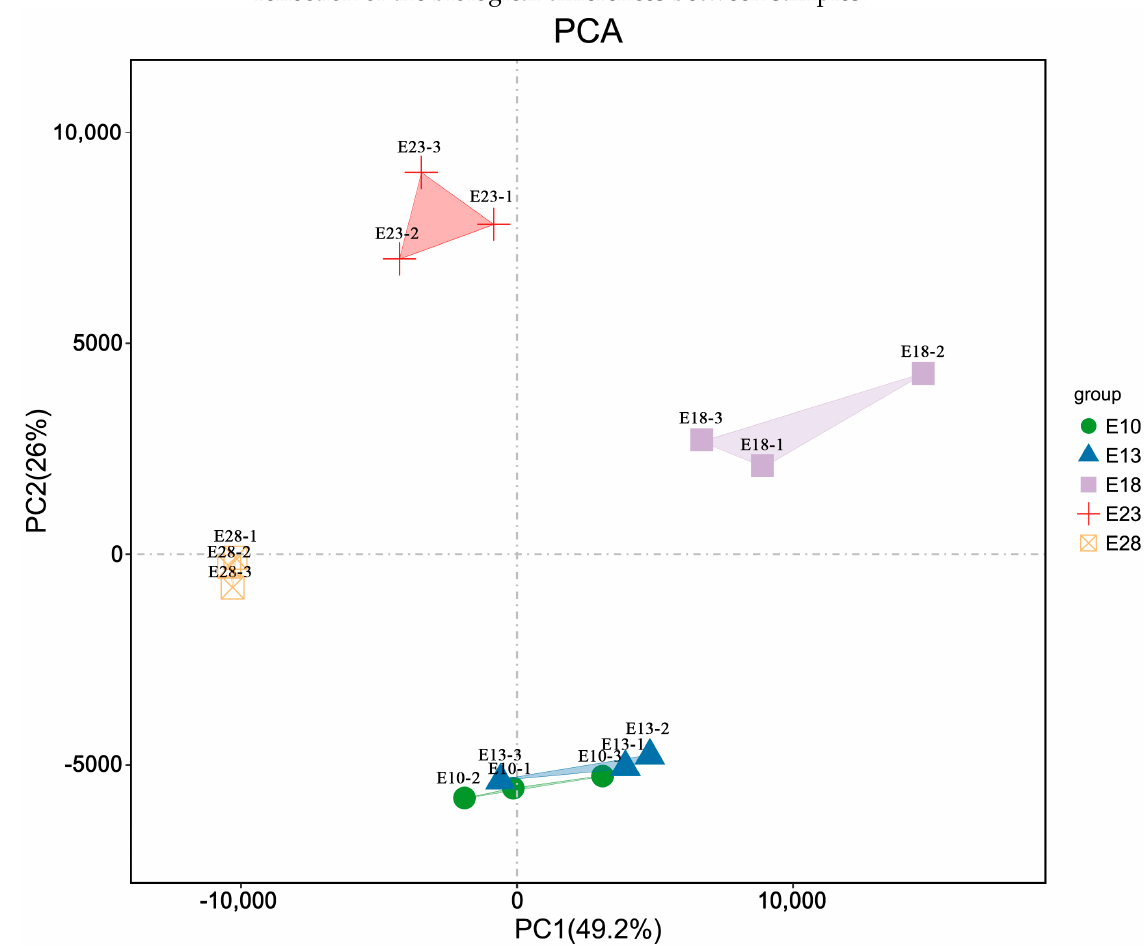
Figure 2. Principal Component Analysis (PCA) relationships between groups. The PC1 coordinate represents the first principal component and the percentage in brackets shows the contribution of the first principal component to the variation in the samples; the PC2 coordinate indicates the second principal component and the percentage in brackets indicates the contribution of the second principal component to the variation in the samples. The colored points in the graph indicate the individual samples.